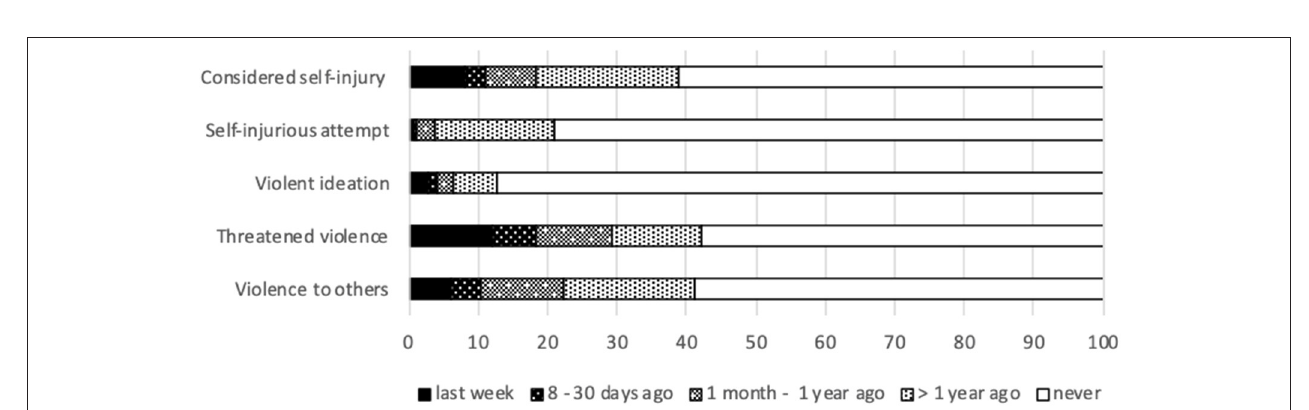
FIGURE 3 | Lifetime prevalence of trauma.